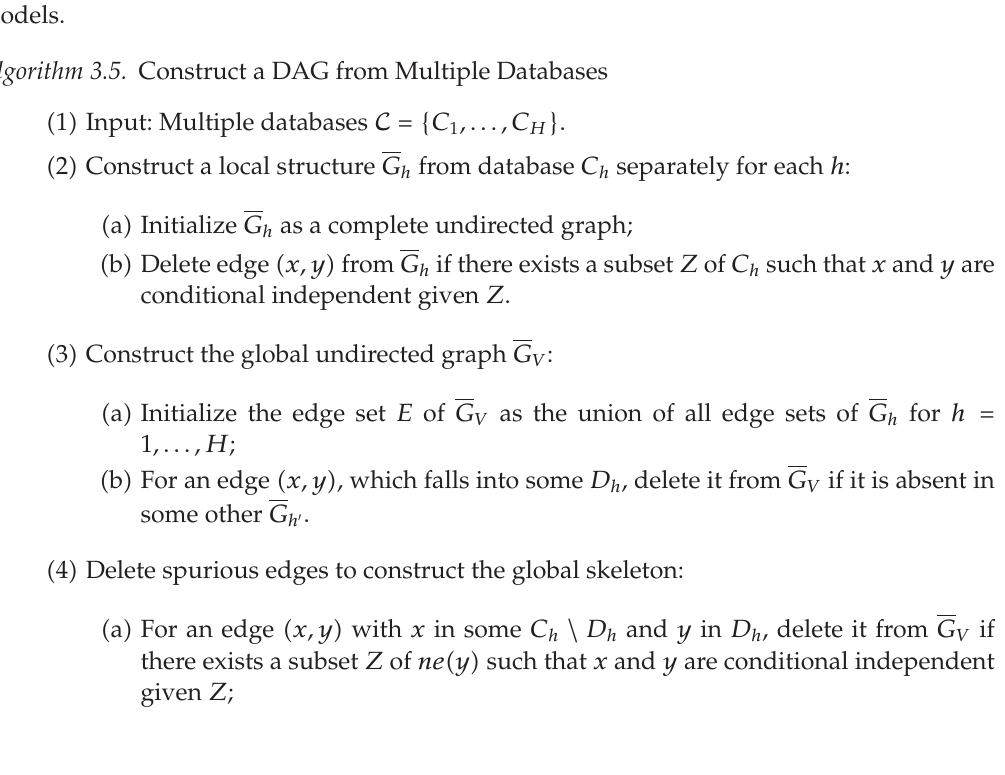
Algorithm 3.5. Construct a DAG from Multiple